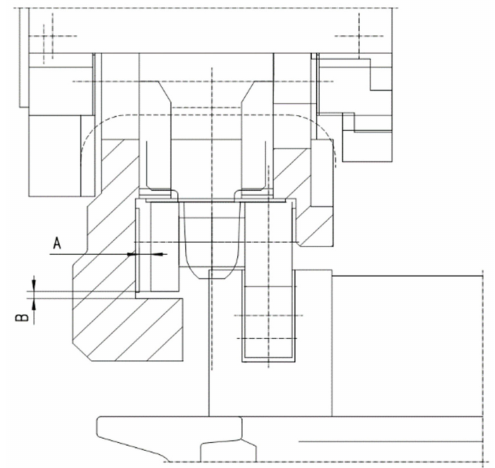
Figure 15. Clearing between the rack and the guiding